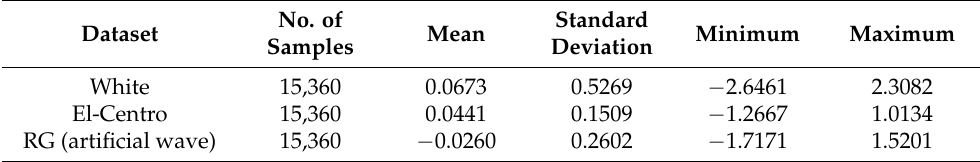
Table 1. Statistical indicators for the three acceleration datasets.